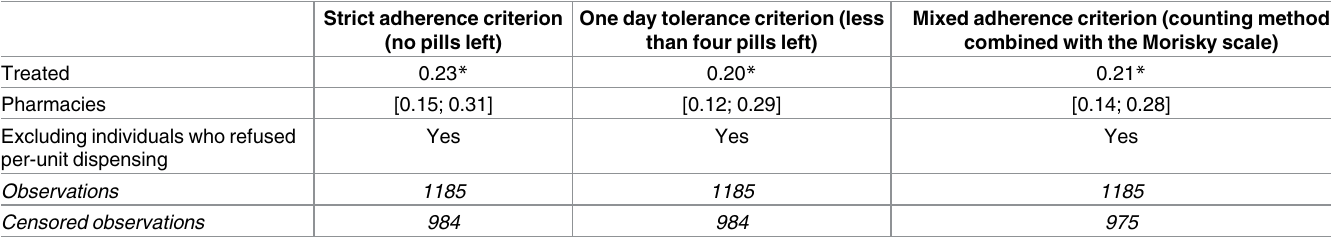
Table 3. Impact on adherence of dispensing exact quantities